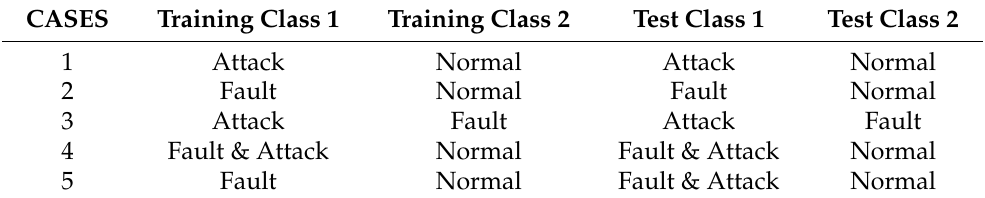
Table 5. Different case scenarios for discriminating between cyber attacks and faults.